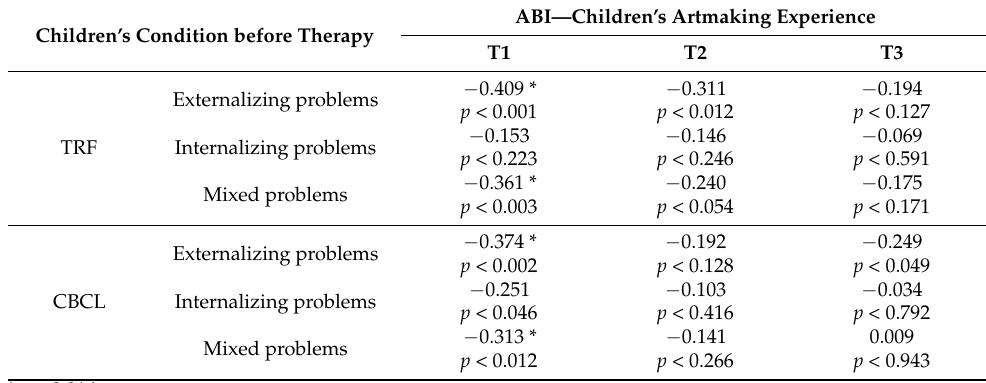
Table 2. Matrix correlates between response to artmaking and behavioral